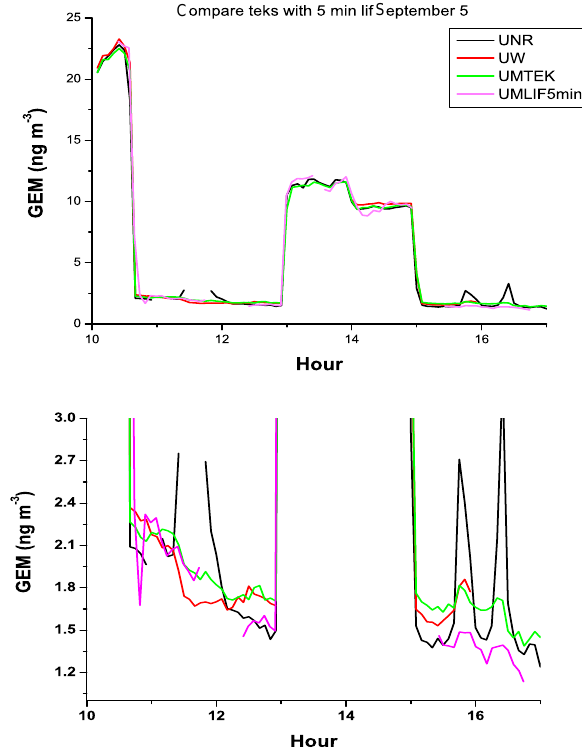
Figure 2. (a) A 7h sequence of GEM measurements from 5 September that included two manifold spikes. Shown are the sequence of GEM measurements from the UNR, UW and UM Tekrans together with the 5min averages of the 2P-LIF signal. (b) An expanded concentration scale focusing on ambient measure-